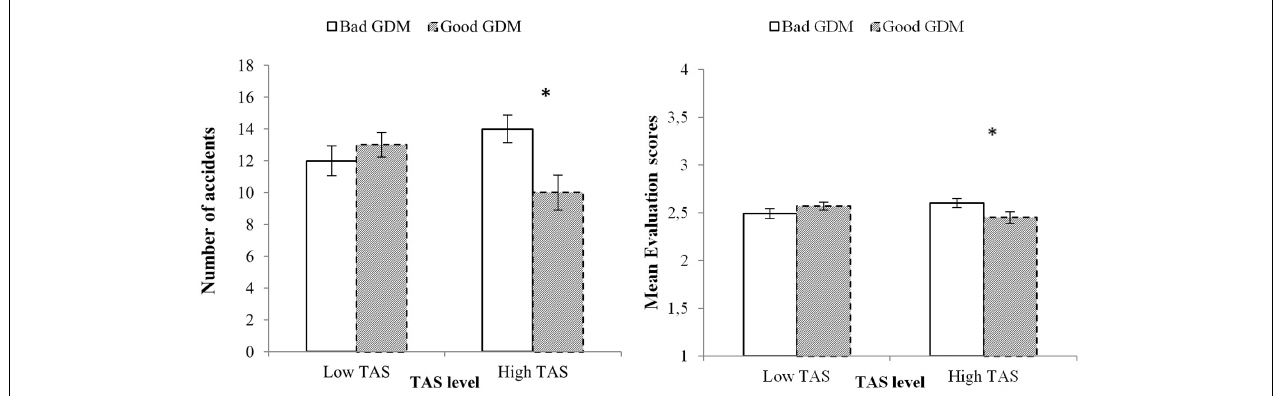
FIGURE 3 | Two-way interaction showing the participants’ Number of accidents (left panel) and Evaluation scores (right panel) for their moped riding performance. The asterisks indicate significant post hoc pairwise comparisons ( p < 0.05) with Bonferroni correction. The Evaluation scores ranged from 1 (better performance) to 4 (accidents), so that higher scores indicated worse performance. Vertical bars represent standard